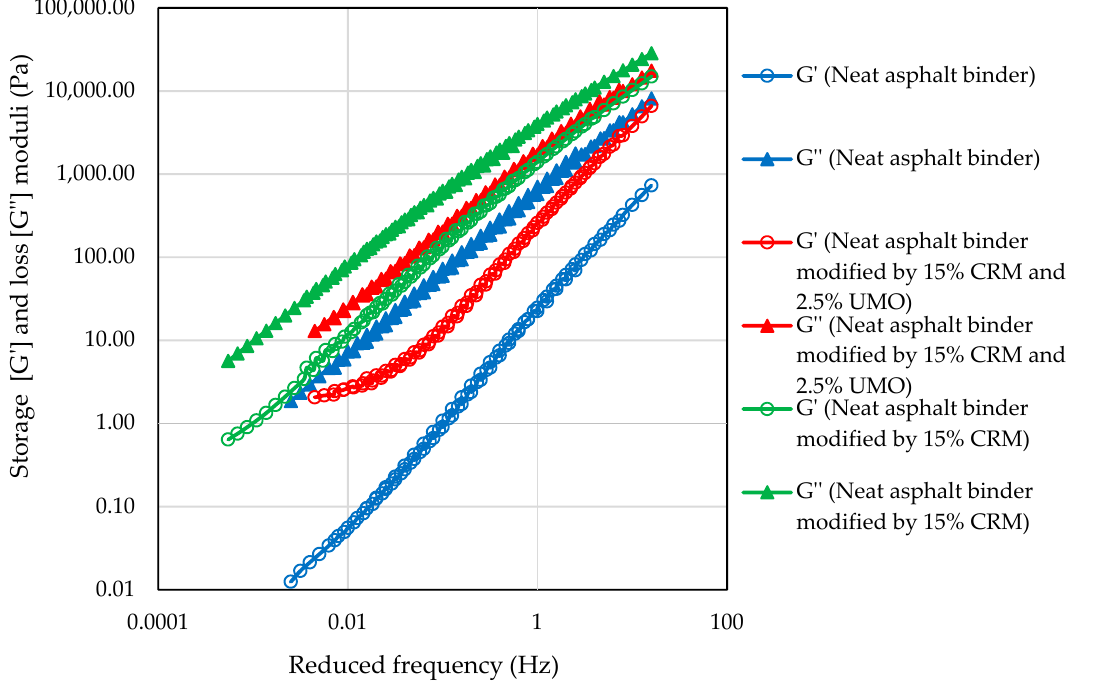
Figure 7. Master curve for PG 52-28 neat and modified asphalt binders interacted at 170 ◦ C—50 Hz—75 min, measured at 60 ◦ C as a reference temperature.